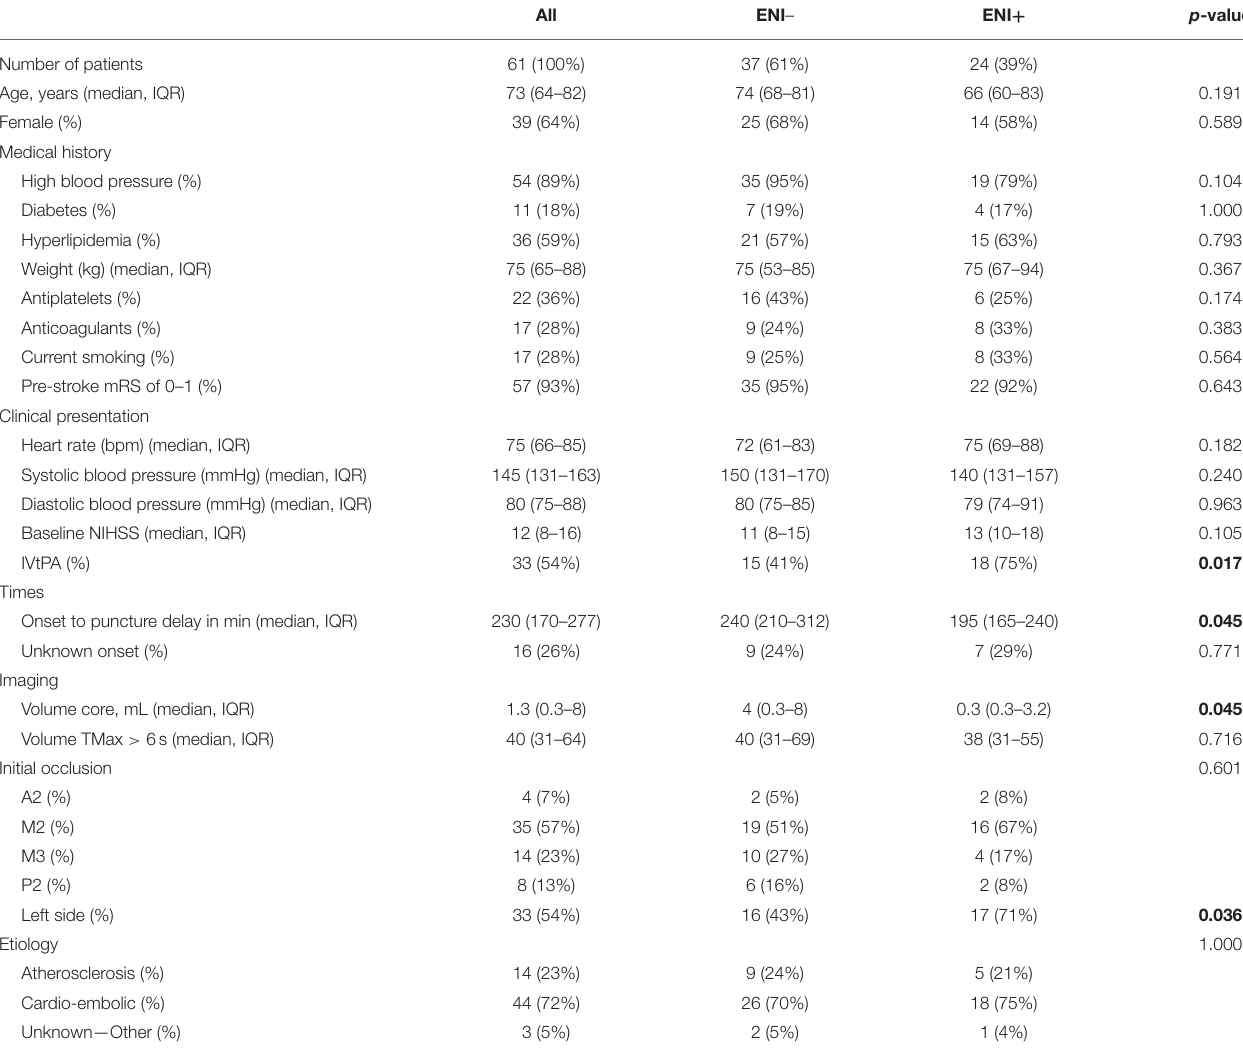
TABLE 1 | Baseline characteristics for patients stratified by early neurological improvement (ENI) status. All ENI – ENI